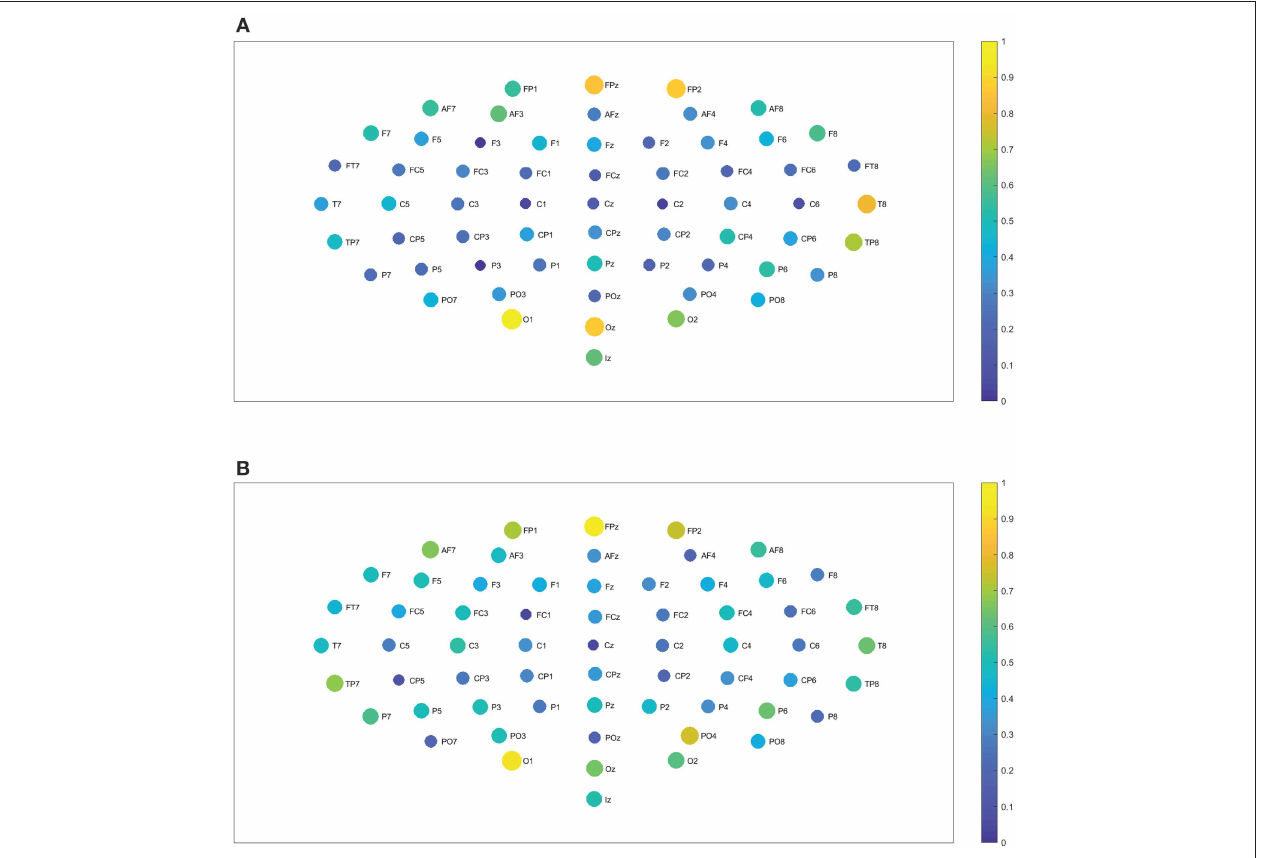
FIGURE 9 | Closeness centrality. (A) Shows the node closeness centrality considering 109 subjects when performing the visuomotor task for the 62-channels EEG considering the oscillation band alpha 2. (B) Is the same as (A) but considering the imagined task. We consider D = 6 and τ = 1. Alpha 2 oscillation band corresponds to [10,13) H